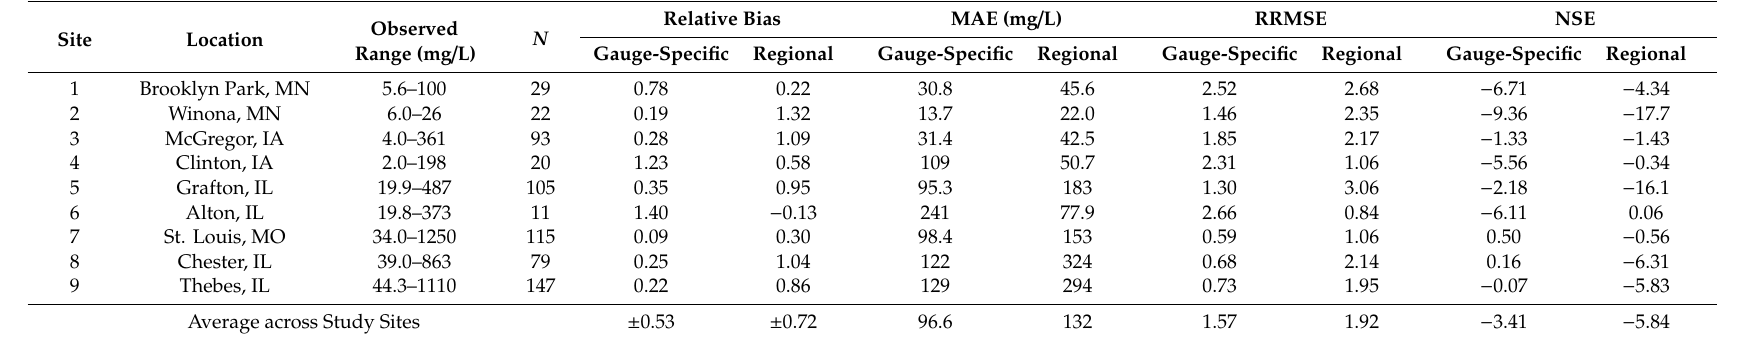
Table 6. Performance of gauge-specific and regional SSC-SR